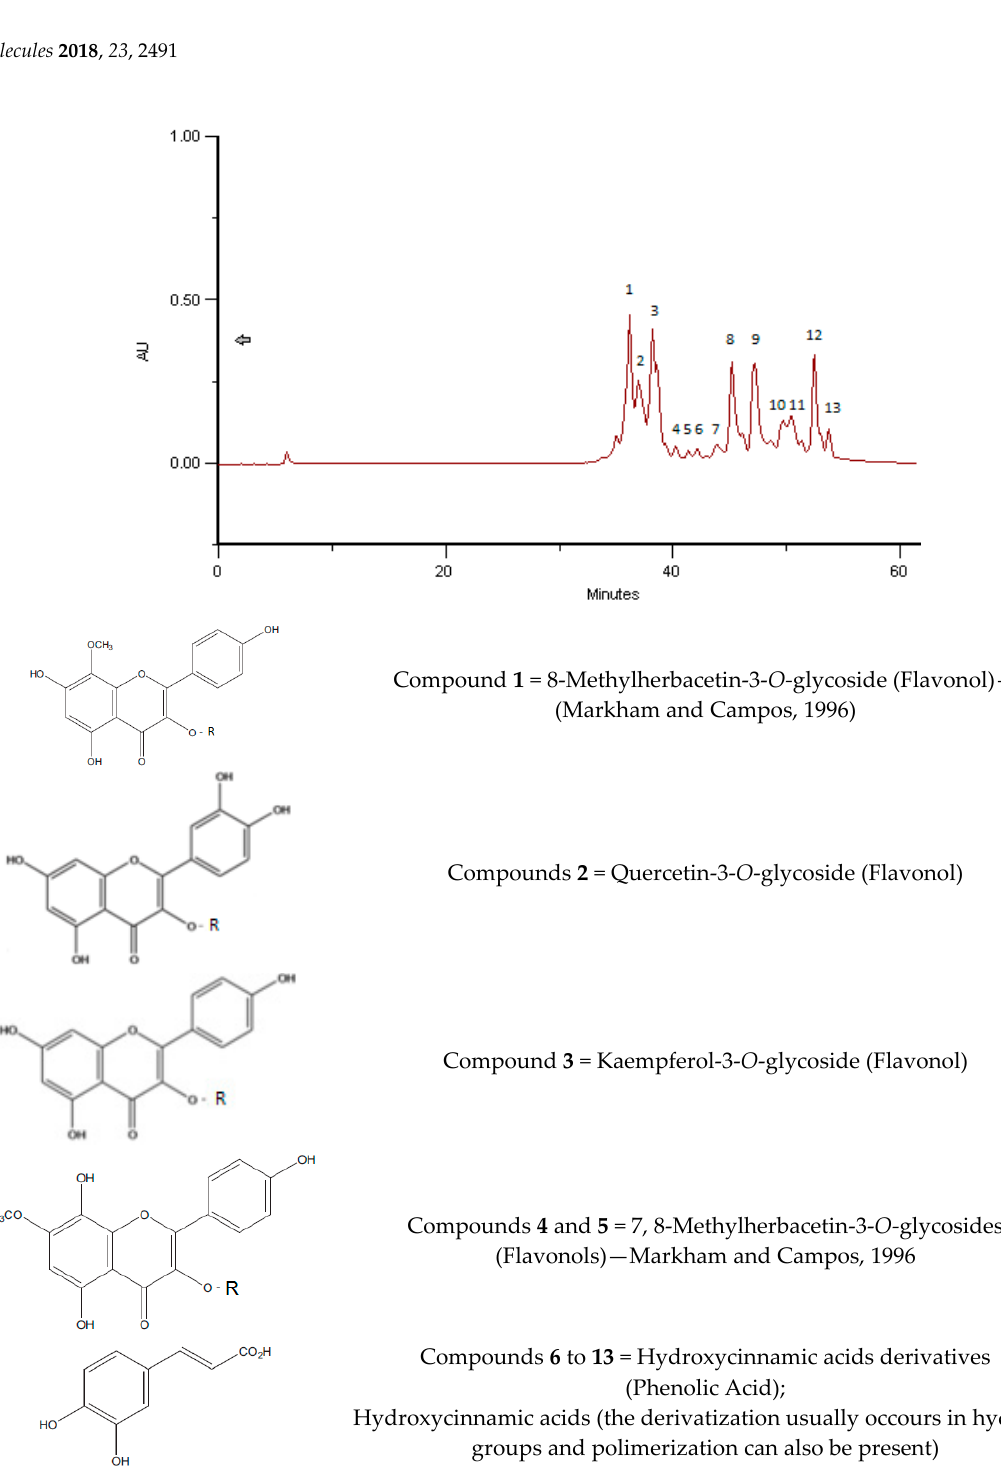
Figure 6. HPLC/DAD profile of BB Romania—April 2016 that correspond to Salicaceae— Salix sp. (61%), Rosaceae— Prunus sp. (26%), Fagaceae— Quercus sp. (13%). Compound 1 = 8-methylherbacetin-3- O -derivative (Markham and Campos, 1996), compound 2 = quercetin-3- O -derivative, compound 3 = Kaempferol-3- O -derivative, compounds 4 and 5 = 7, 8-methylherbacetin-3- O -derivative (Markham and Campos [37]). All additional compounds are phenolic acid derivatives (data in line with Campos and Markham [34]).